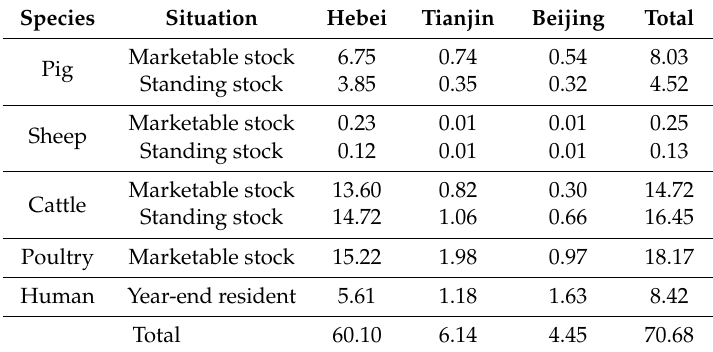
Table 9. The estimation of feces waste for biogas production (10 8 m 3 ).